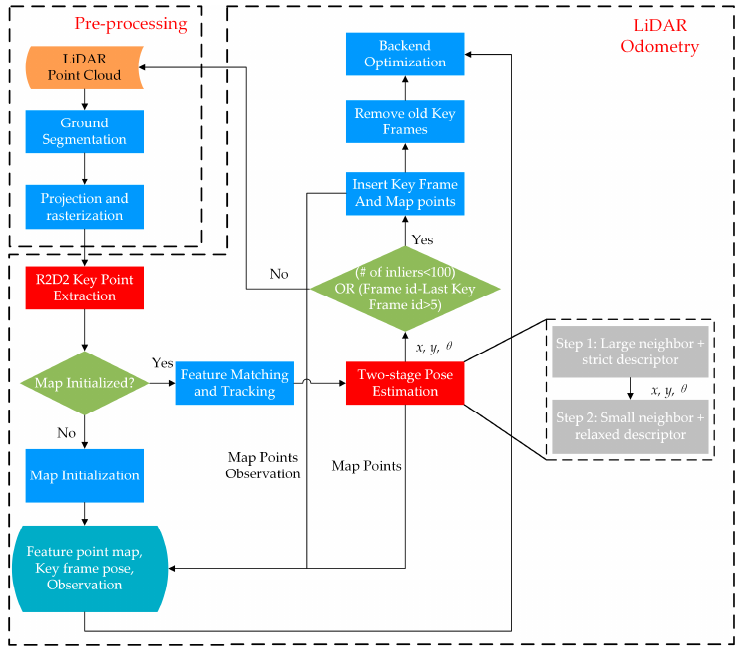
Figure 1. Workflow of the proposed LiDAR odometry algorithm. Showing the pre-process of LiDAR data and steps involved in mapping, pose estimation, and